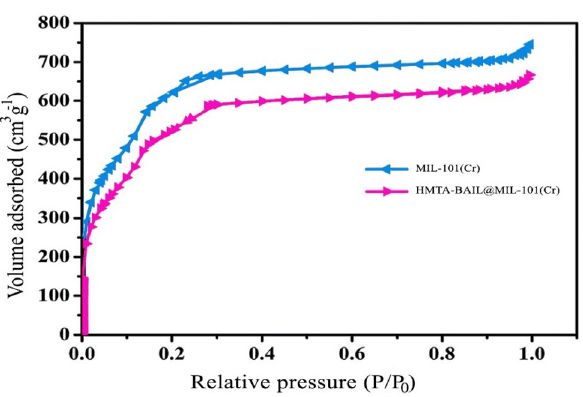
Figure 6. The N 2 adsorption–desorption isotherms of MIL-101(Cr) and